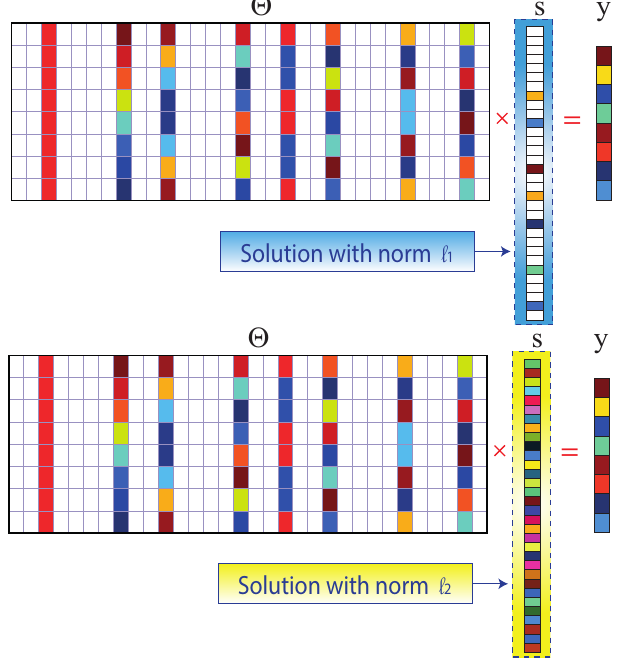
Figure 8. L1 and L2 minimum standard solutions to the compressed sensing problem. If white noise is immersed in the signal under test, Equation (5) should be varied to obtain the more robust Equation (6). With more samples per cycle, the system gains robustness to noise. Furthermore, the system is more robust to noise if a sufficiently large dispersity level k is used, i.e., a more significant number of cycles to be analyzed. Thus, Equation (6) is included in the algorithm to mitigate the noise immersed in the signal. The error also depends on the dictionary used; therefore, when a random type